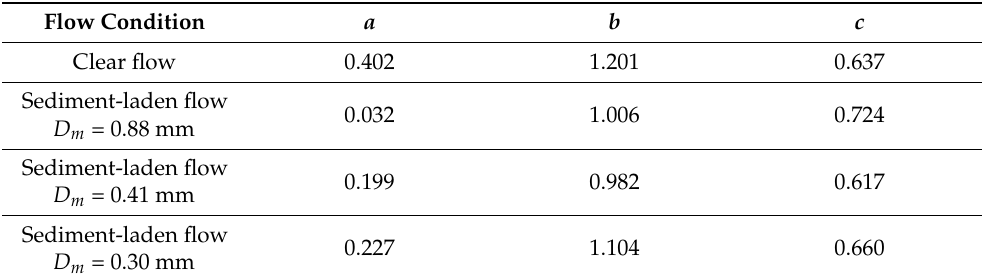
Table 1. Values of coefficients of Equation (13).